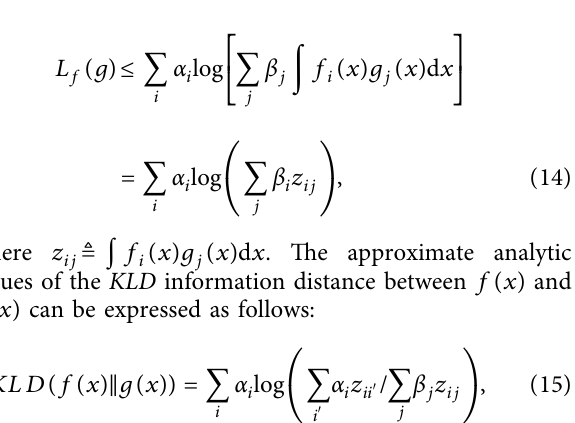
Figure 13: The simulation results when a target appears at Position C . (a) The 3D KLD information distance distribution. (b) The 2D KLD information distance